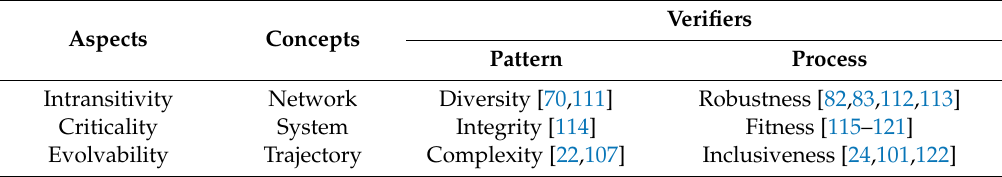
Table 1. The conceptual framework for assessing habitat